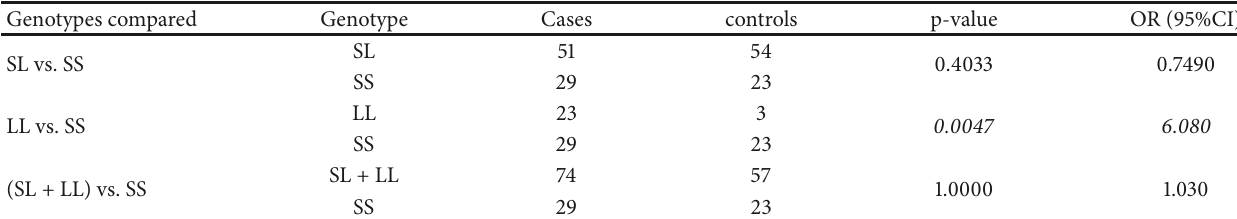
Table 3: Risk assessment of the different